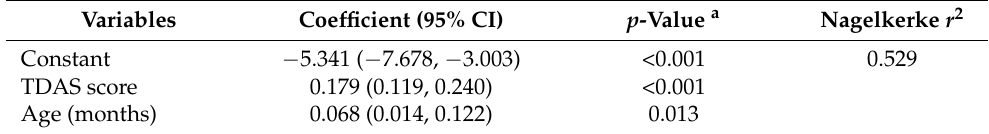
Table 5. Factors associated with ASD according to the DSM-5 ASD criteria (N =